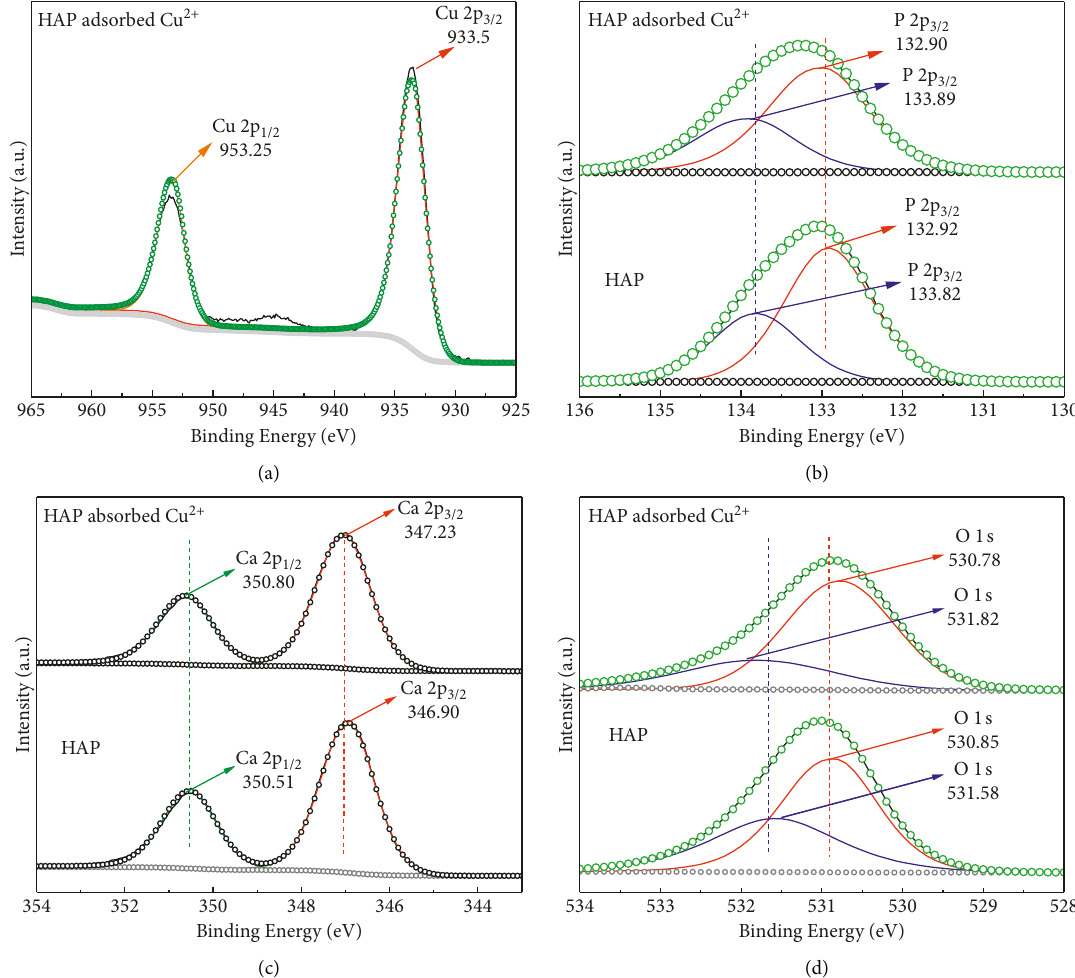
Figure 5: XPS spectra before/after adsorbing copper by hydroxyapatite. (a) Cu 2p XPS spectra. (b) P 2p XPS spectra. (c) Ca 2p XPS spectra. (d) O 1s XPS spectra.